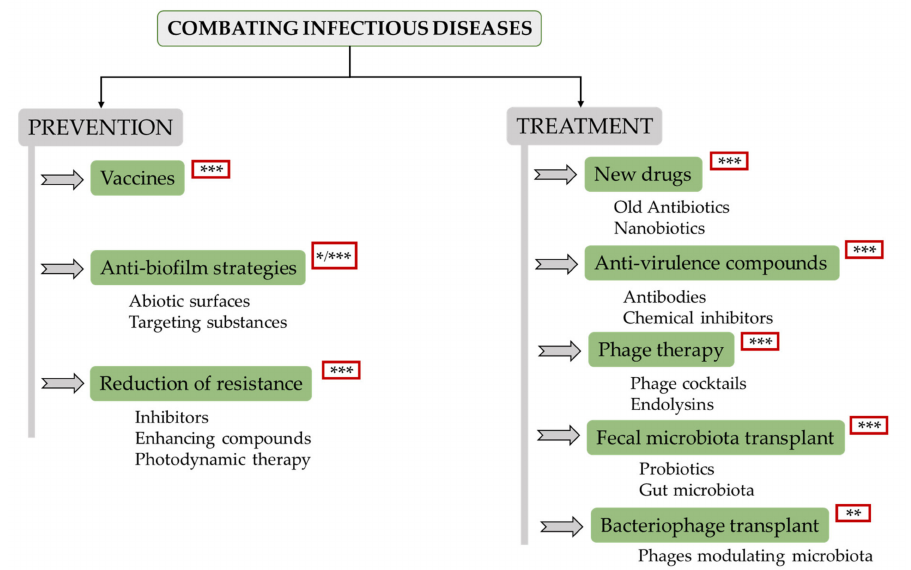
Figure 2. Overview scheme of potential alternatives to antibiotics that are currently under development. Level of development: * (low, laboratory research); ** (medium, animal models); *** (high, clinical